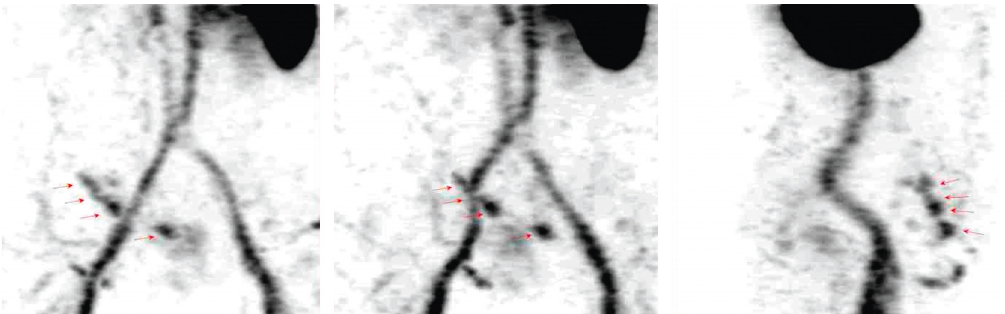
Figure 2: Red blood cell nuclear scan showing variceal vessels in the area of the hernia.